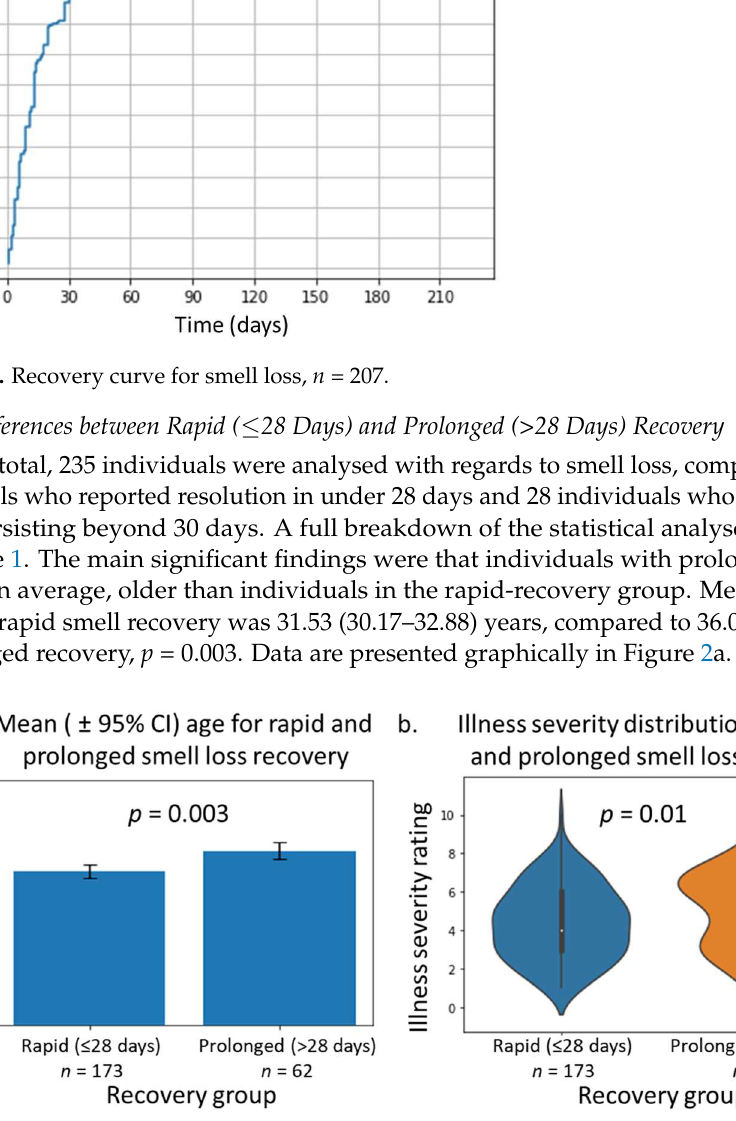
Figure 2. ( a ) Comparison of age between rapid and prolonged smell recovery; p -values are for two-tailed t -test. ( b ) Comparison of illness severity between rapid and prolonged smell recovery; p -values are for Mann–Whitney test.